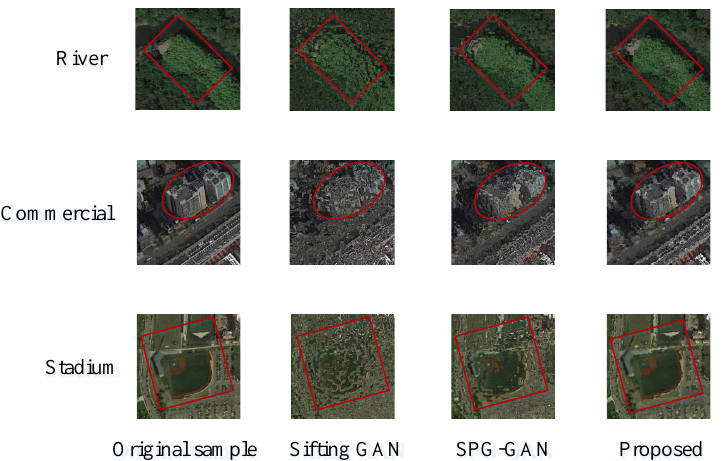
Figure 8. Comparison of samples generated by our approach and other approaches on the AID